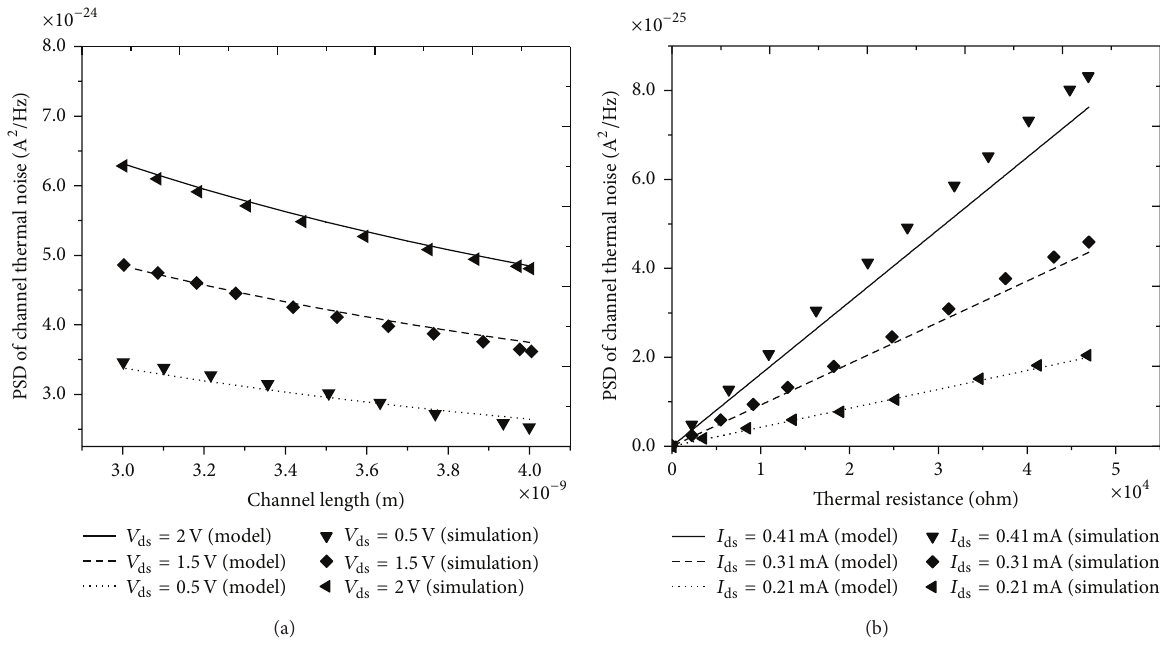
Figure 3: (a) Power spectral density of channel thermal noise versus channel length of the SNWMOSFET. (b) Power spectral density of channel thermal noise versus thermal resistance of the SNWMOSFET.